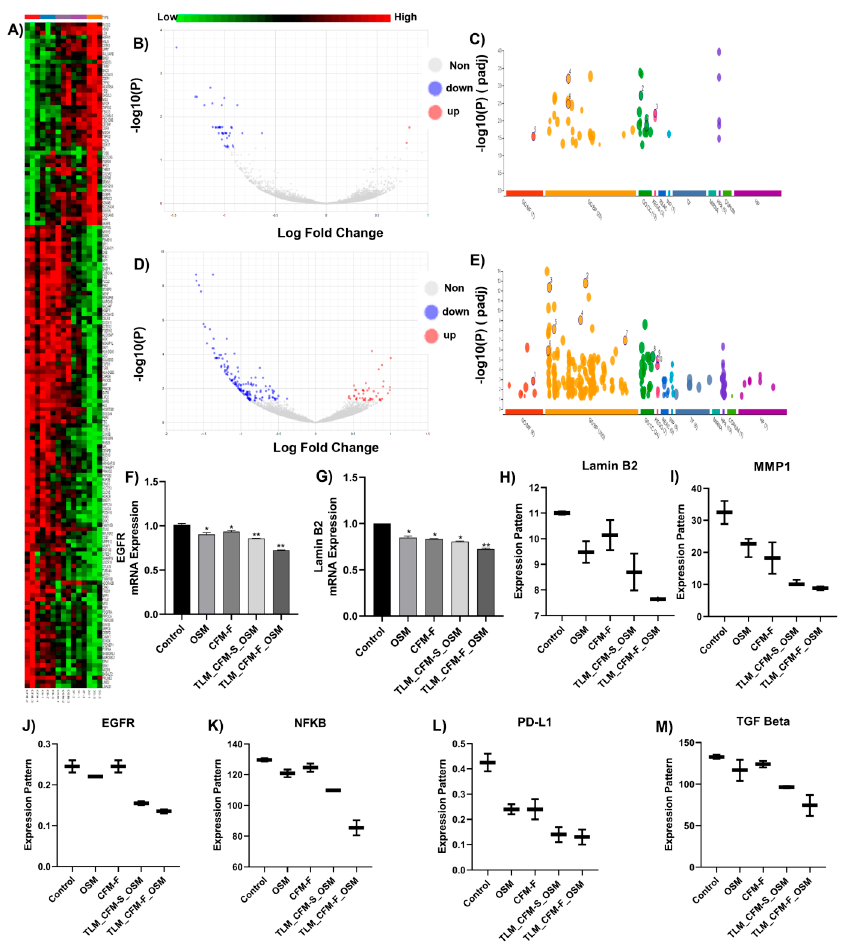
Figure 2. RNA-Seq identified differential mRNA expressions and their RTPCR validation in NSCLC tumor tissues isolated from athymic nude mice ( A ) Heat map illustrations of hierarchical clustering analysis of differentially expressed mRNA in tissues of control and treated H1975 Xenograft mice. Representative volcano plots of differentially expressed genes (DEGs) in between ( B ) control and TLM_CFM-F_OSM groups, ( C ) control and TLM_CFM-S_OSM groups. Representative Gene ontology (GO) and Kyoto Encyclopedia of Genes and Genomes (KEGG) annotation analysis in between ( D ) control and TLM_CFM-F_OSM groups and ( E ) control and TLM_CFM-S_OSM groups. Representative bar graphs show RT-PCR analysis of ( F ) Lamin B2 and ( G ) EGFR. Representative box plots show transcriptomic expressions of ( H ) Lamin B2, ( I ) MMP1, ( J ) EGFR, ( K ) NFKB, ( L ) PD-L1, and ( M ) TGF beta. Data were represented as the mean ± SD of three separate experiments ( n = 3). ** p < 0.01, * p < 0.05 vs. control.